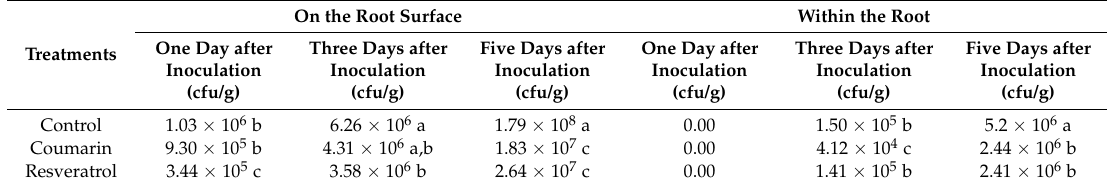
Table 3. Effects of coumarin and resveratrol on rhizosphere colonization of R. solanacearum in tobacco.